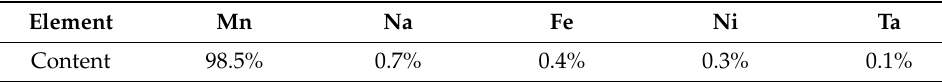
Figure 7. Precipitation rate of manganese. Table 5. The metals compounds of Mn(OH) 2 after precipitation.